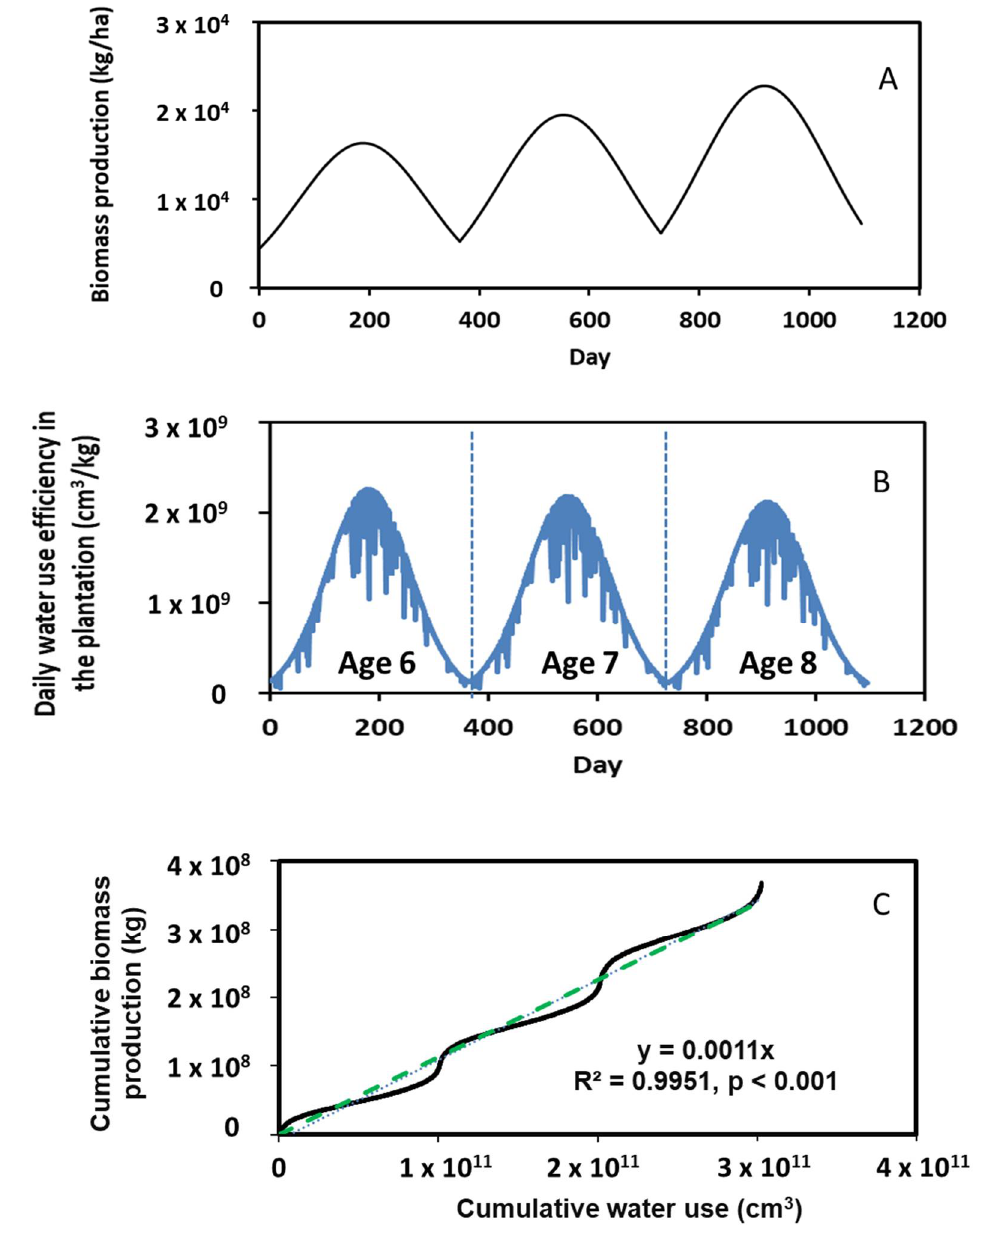
Figure 7. Simulated biomass production, water use efficiency, and relationship of cumulative bio- mass and water use during the 3-year period. and water use during the 3-year